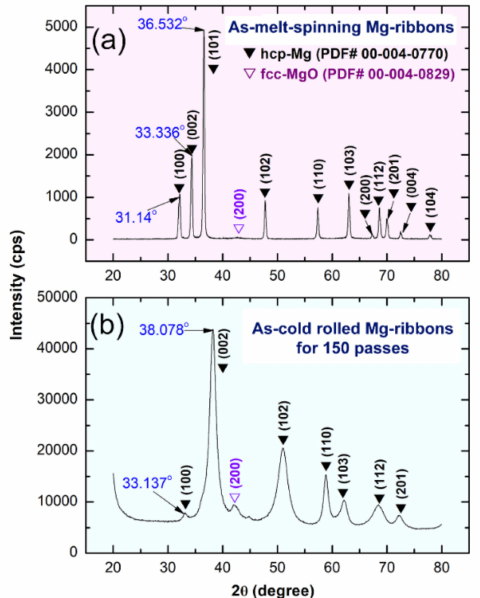
Figure 4. X-ray di ff raction (XRD) patterns of Mg-ribbons after CR for ( a ) 0 passes, and ( b ) 150 passes. When the ribbons were cold-rolled for 25 passes, they revealed obvious micro-intimated bands that have developed as a result of the shear stresses applied to them during the CR process (Figure 3c). This was confirmed by the BF-TEM image of a cross-section view of the as-CR Mg ribbons obtained after 25 passes that revealed lattice imperfections beyond the atomic level, as indexed by the